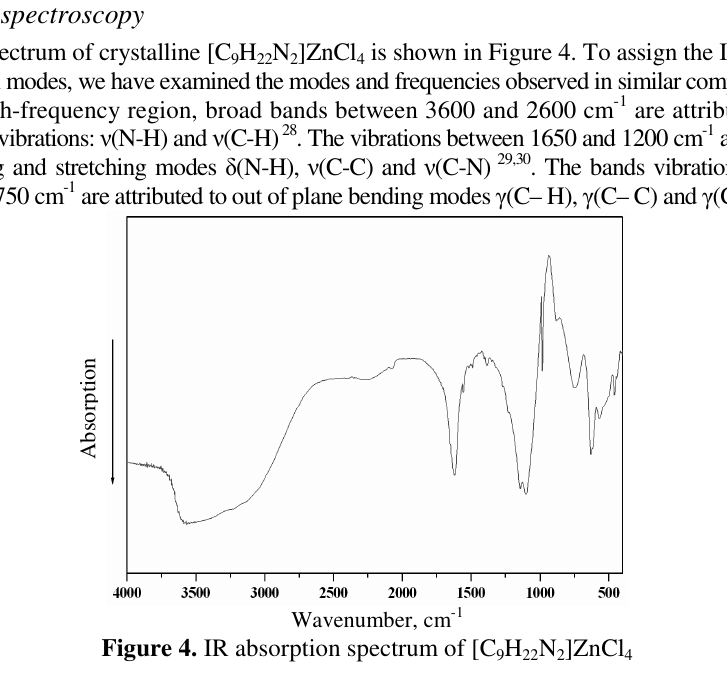
H N ]ZnCl 9 22 2